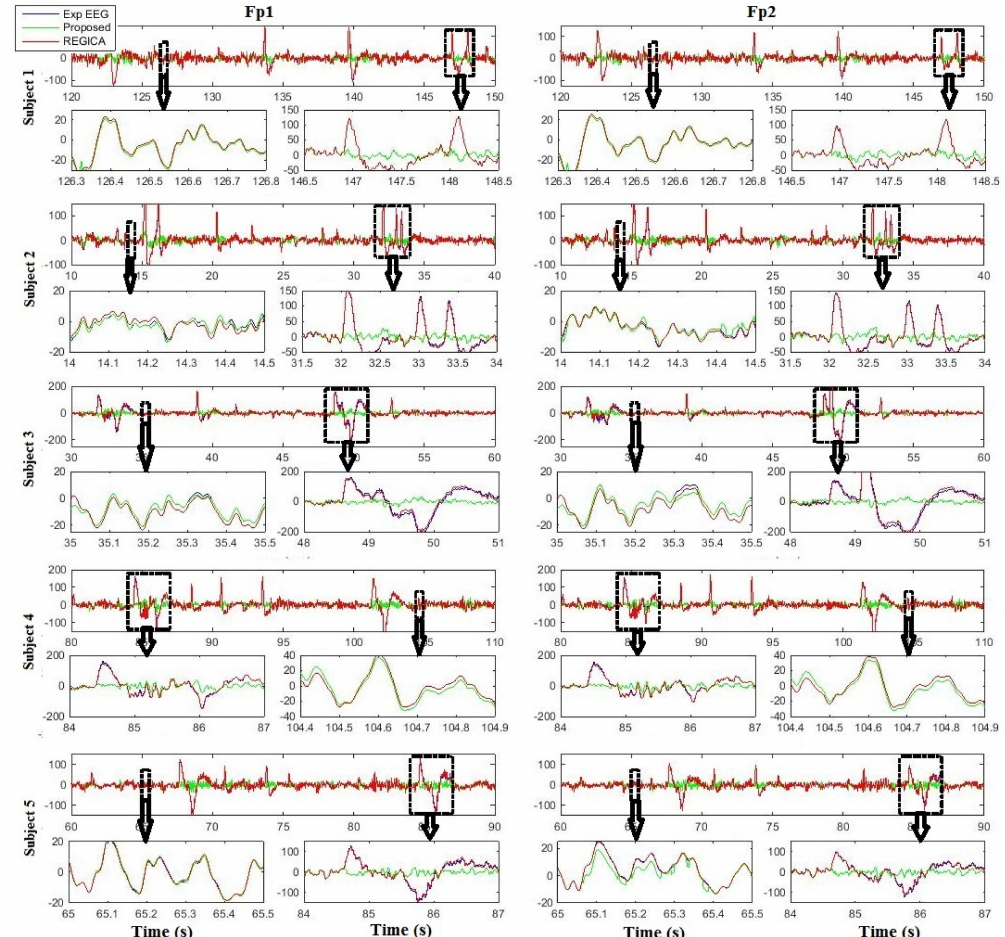
Figure 8. Comparison results of the proposed algorithm and REGICA for all subjects at Fp1 and Fp2.